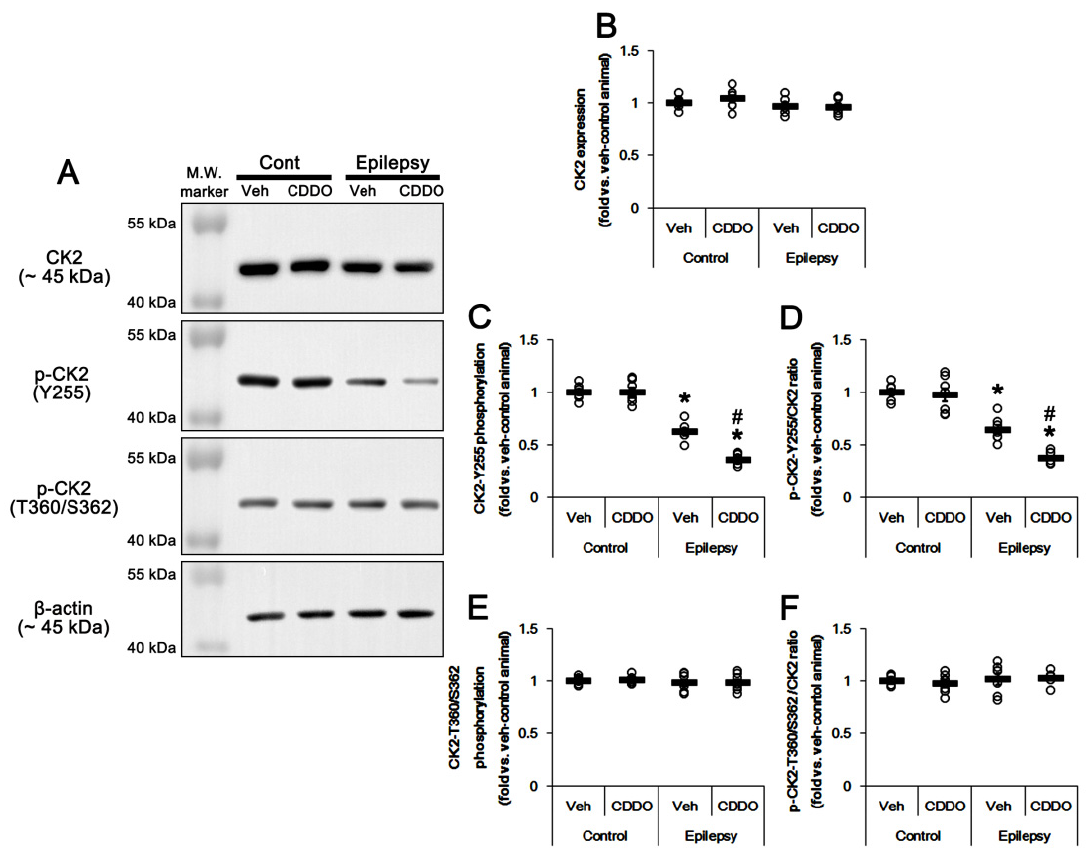
Figure 5. Effects of CDDO-Me on CK2 and p-CK2 levels in the CA1 region of control and epileptic rats. As compared to control animals (Cont), casein kinase 2 (CK2)-Y255, but not T360/S362, phosphorylation was reduced in the CA1 region of epileptic rats without altering its expression level. CDDO-Me treatment decreased CK2-Y255 phosphorylation more in epileptic rats. ( A ) Representative Western blot for CK2 and p-CK2 in the CA1 regions. ( B – F ) Quantitative values (mean ± SEM) of protein, phosphorylation and phosphorylation ratio concerning CK2 ( B ), p-CK2-Y255 ( C , D ) and p-CK2-T360/S362 ( E , F ) ( n = 7). Open circles indicate each value. Horizontal bars indicate the mean value. Significant differences are * ,# p < 0.05 vs. control animals and vehicle-treated animals.